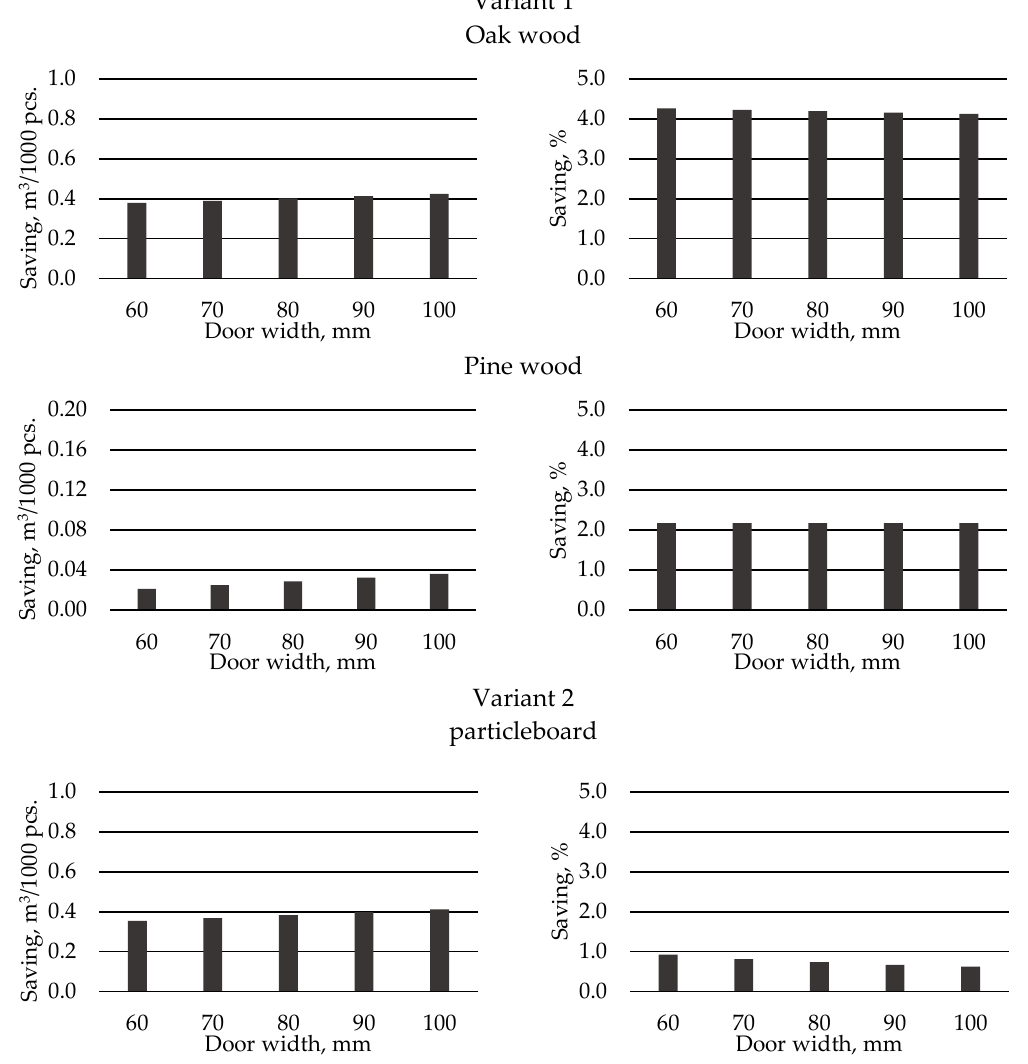
Figure 10. Material savings obtained by reducing the machining allowance in construction 4.